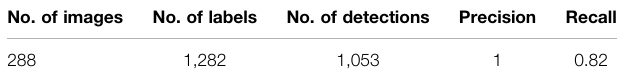
TABLE 4 | Numbers of images and labels and the detection